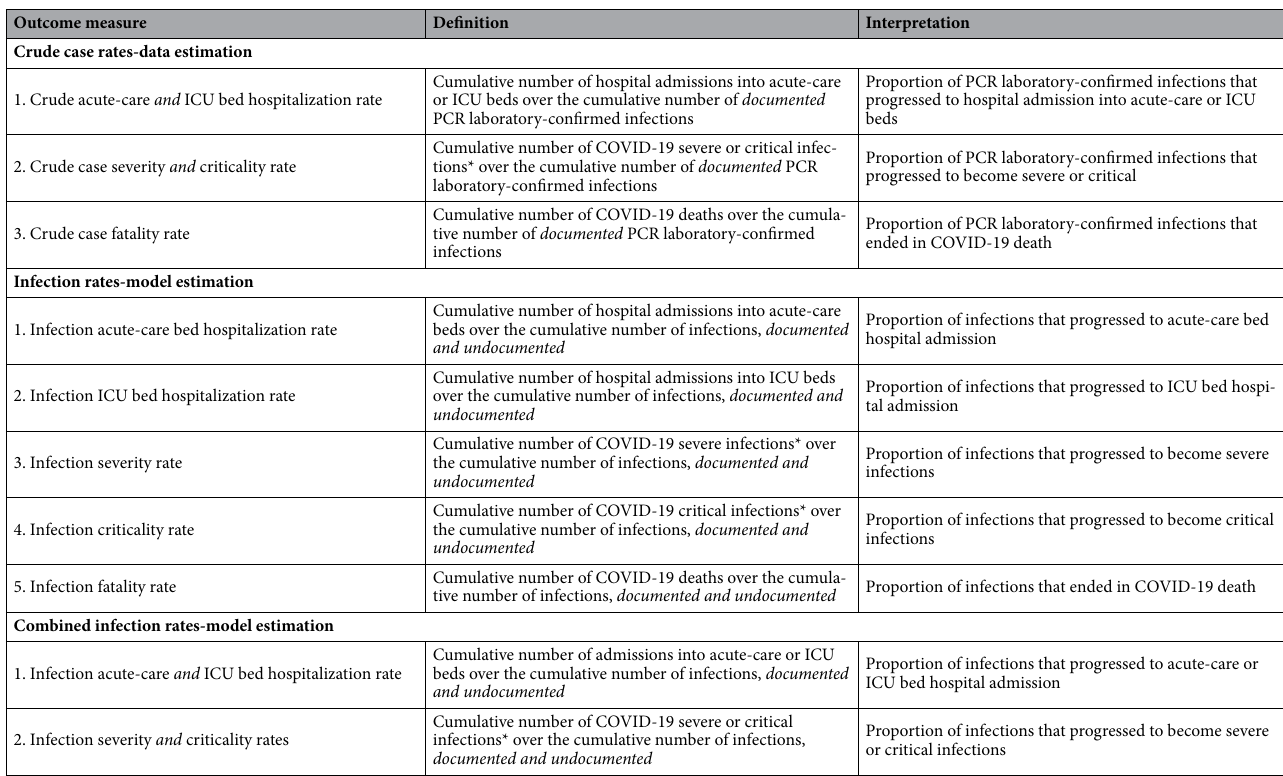
Table 1. Crude case rates and infection rates estimated in this study. *Per World Health Organization (WHO) infection severity classification 11